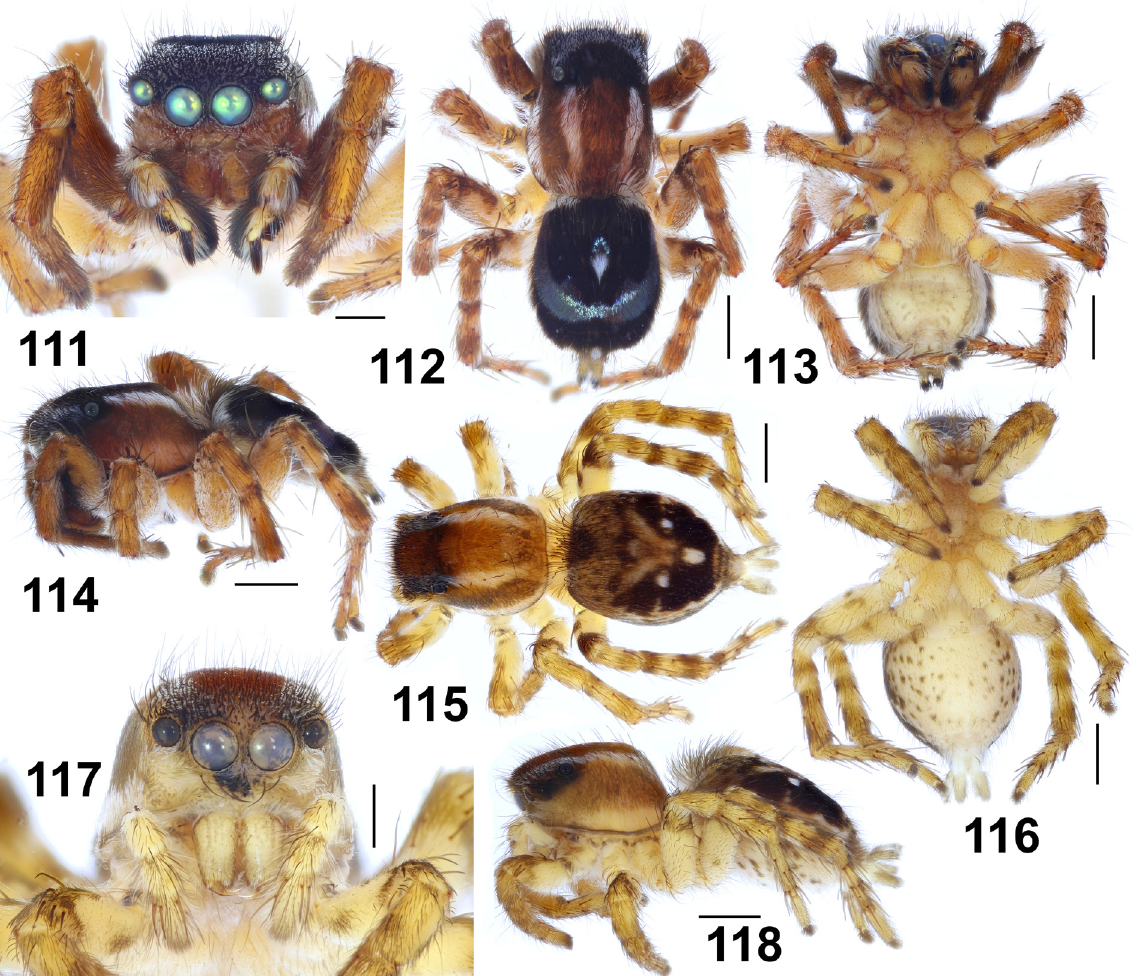
Figs 111–118. Stenaelurillus darwini Wesołowska & Russell-Smith, 2000 from Tanzania (Mkomazi GR; MMUE G7571.48, 50), general appearance. 111–114 . ♂. 115–118 . ♀. Scale bars: 1